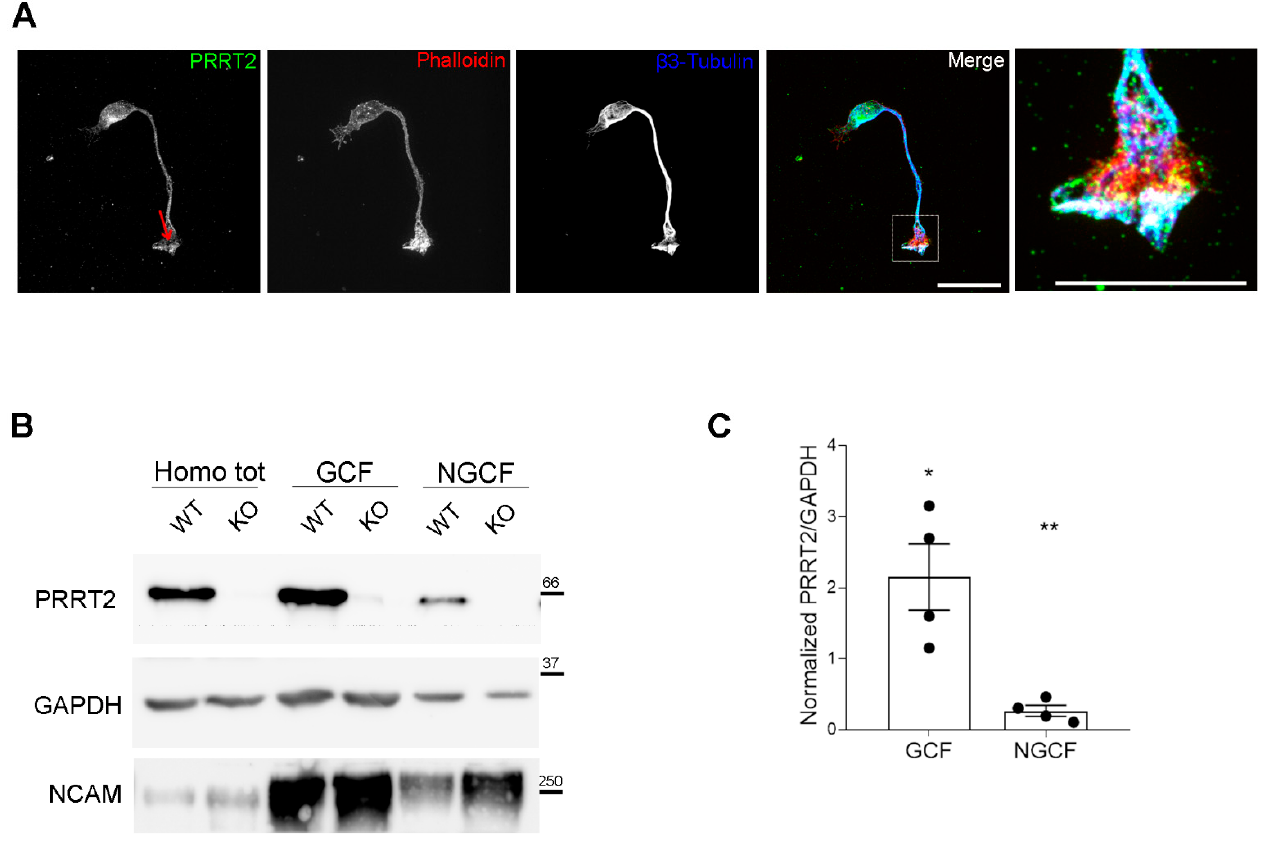
Figure 1. PRRT2 is enriched in the growth cones of in vitro developing neurons. ( A ) 1 DIV hippocampal neurons processed for immunofluorescence and stained for endogenous PRRT2, actin, and β III-tubulin. Red arrow points to PRRT2 signal at the growth cone. The panel on the right shows a higher magnification of the inset in the Merge panel. Note the white signal at the tip of the growth cone, indicating overlapping of the signals for PRRT2, actin, and β III-tubulin. Scale bar = 20 µ m, inset scale bar = 10 µ m. ( B ) Representative immunoblot of PRRT2 and NCAM in post-nuclear supernatant fraction (Homo tot), growth cone (GCF), and non-growth cone (NGCF) fractions from WT and PRRT2 KO P2/P3 brains. ( C ) Quantification of PRRT2 enrichment in WT fractions. PRRT2 band intensity was normalised on GAPDH for each sample and on the homogenate level, which was set to 1. Data are expressed as mean ± SEM of n = 4 embryos (Homo tot: 1, GCF: 2.2 ± 0.9, NGCF: 0.3 ± 0.1). One ‐ way ANOVA + Tukey’s test; * p < 0.05 homo tot vs GCF, ** p < 0.01 GCF vs NGCF.